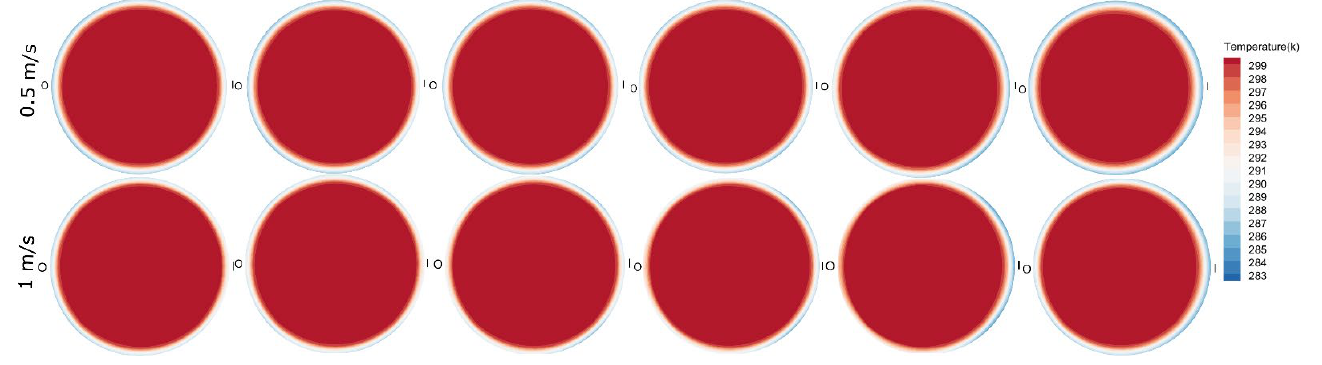
Figure 11. Temperature distributions on the five sections and the outlet plane of the U-shaped channel. From the left to the right, the order of these sections is from the inlet to the outlet of the channel. The upper row shows the data at the inlet velocity of 0.5 m/s at the temperature conditions of 283 K on the wall and 300 K of the incoming fluid at the inlet. The lower row shows the data at the inlet velocity of 1 m/s at the temperature conditions of 283 K on the wall and 300 K of the incoming fluid at the inlet.